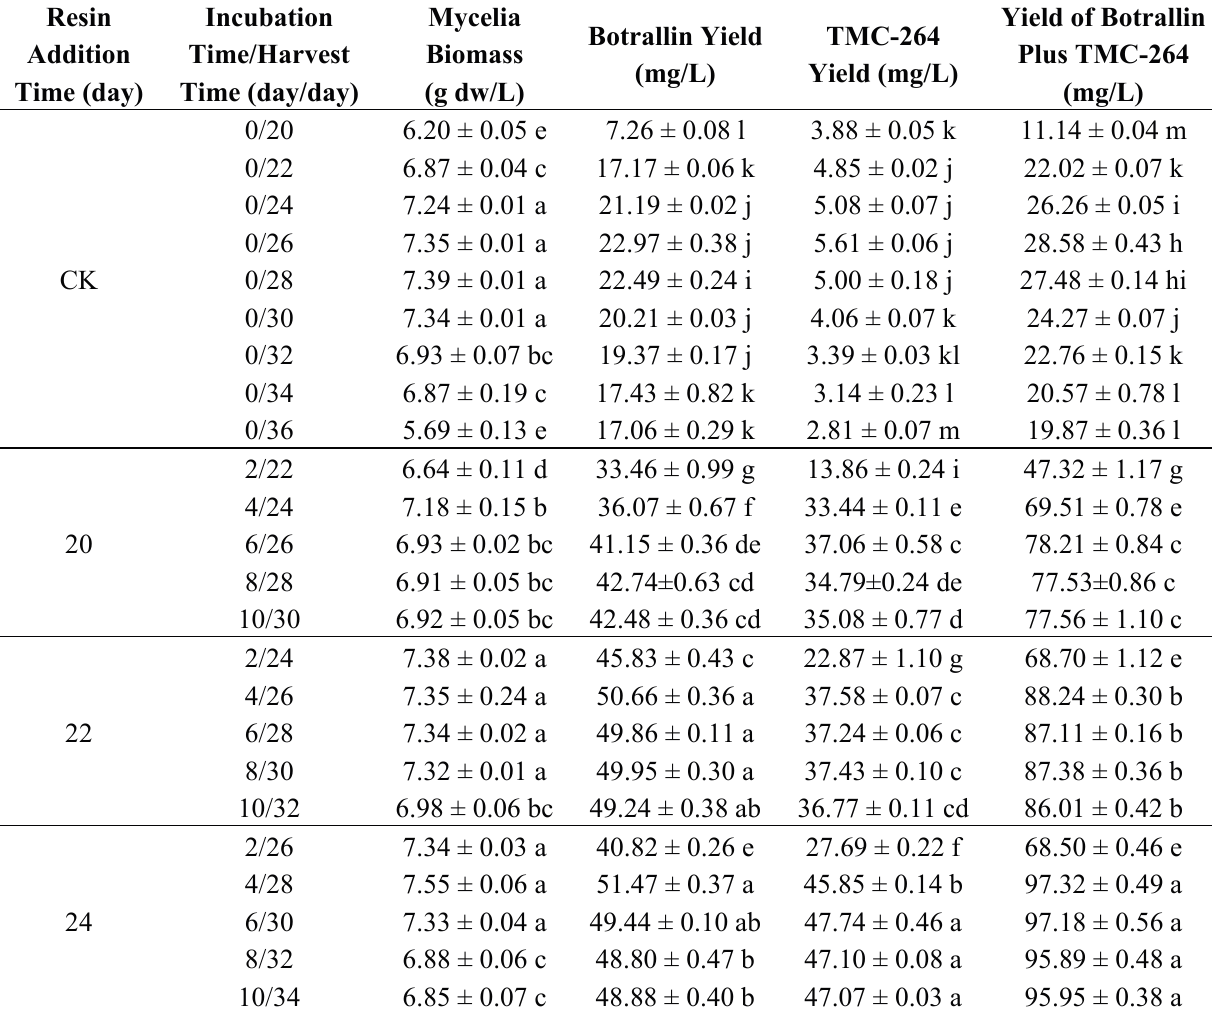
Table 3. Effects of addition and incubation time of DM-301 resin on mycelial growth